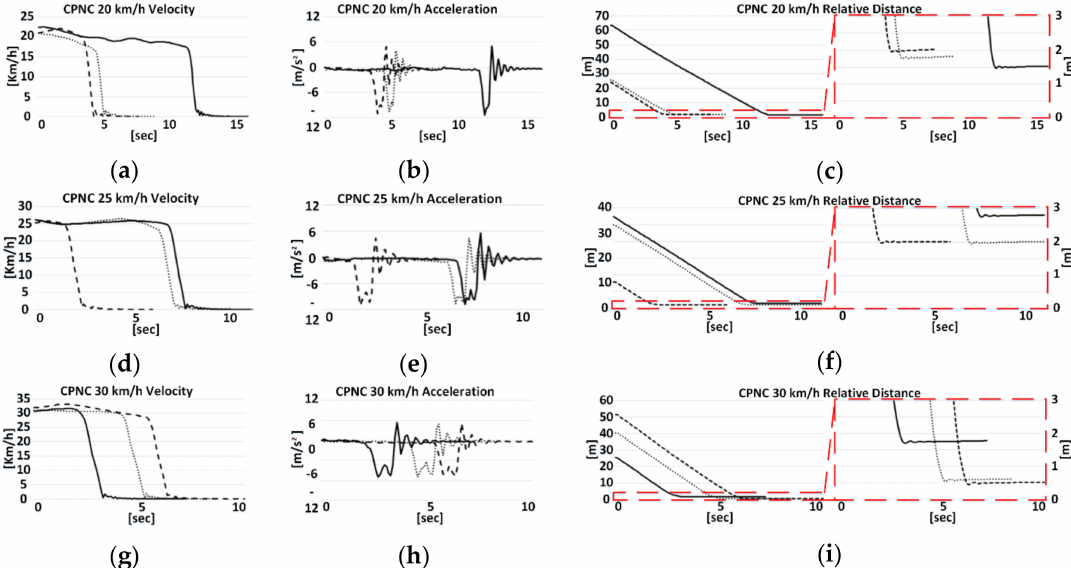
Figure 13. Test results(CPNC) ( a ) 20 km / h test velocity & cumulative delay time ( b ) 20 km / h test acceleration ( c ) 20 km / h test relative distance ( d ) 25 km / h velocity & cumulative delay time ( e ) 25km / h test acceleration ( f ) 25 km / h test relative distance ( g ) 30 km / h velocity & cumulative delay time ( h ) 30 km / h test acceleration ( i ) 30 km / h test relative